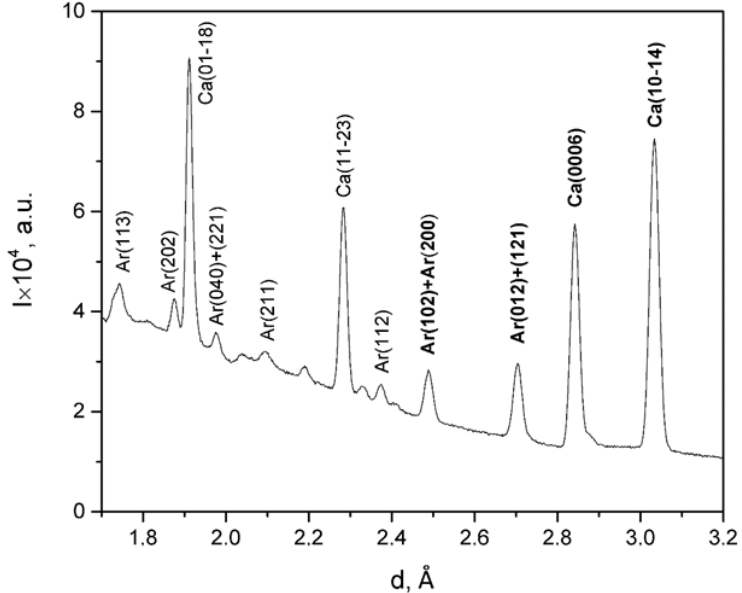
Figure 2. The sum diffraction pattern for mussel shells from station 2 (Langebaan). Either only the left or only the right valves were used. They were studied as a whole, and not as valves surface fragments as is the case of backscattered electron diffraction or X-ray texture